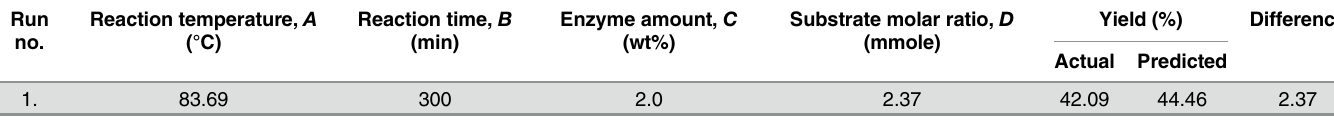
Table 4. Optimum conditions for Novozym 435 catalysed synthesis of KMO ester. Run Reaction temperature, no.